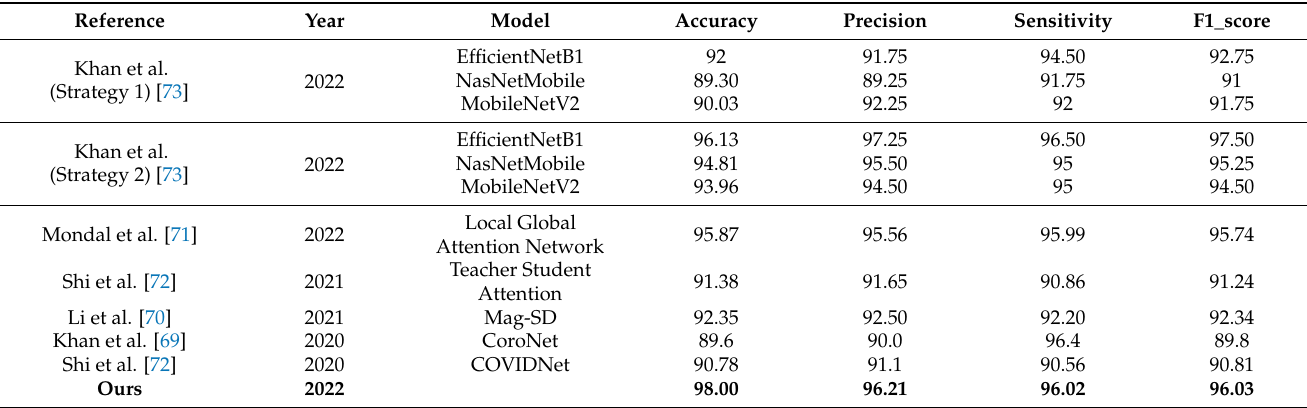
Table 11. Proposed model classification performance comparison with state-of-the-art models using Data_A.